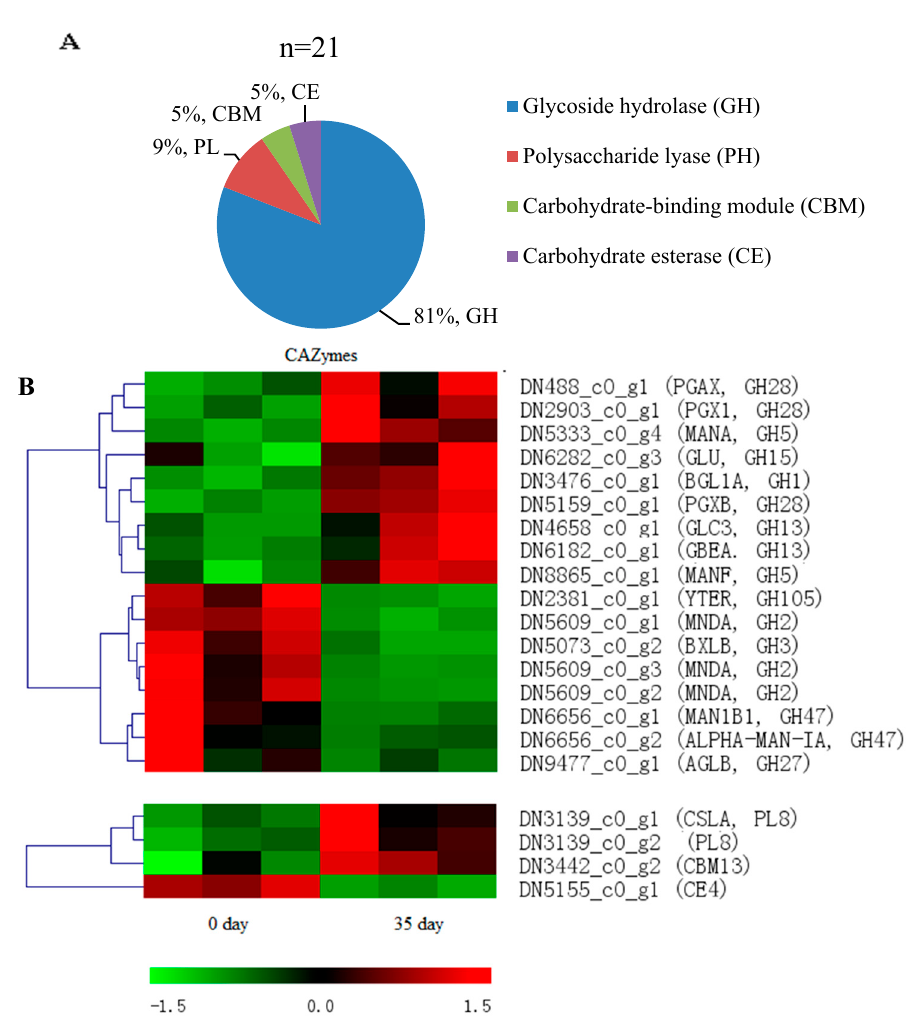
Figure 7. CAZymes analysis involved in mycelia physiological maturation. ( A ) the distribution of CAZymes identified. The corresponding genes were searched using the carbohydrate-active enzyme database (CAZy) and were classified into primary domains such as glycoside hydrolase (GH), carbohydrate-binding module (CBM), carbohydrate esterase (CE), glycosyl transferase (GT), and polysaccharide lyase (PL). ( B ) The expression heatmap of these genes.